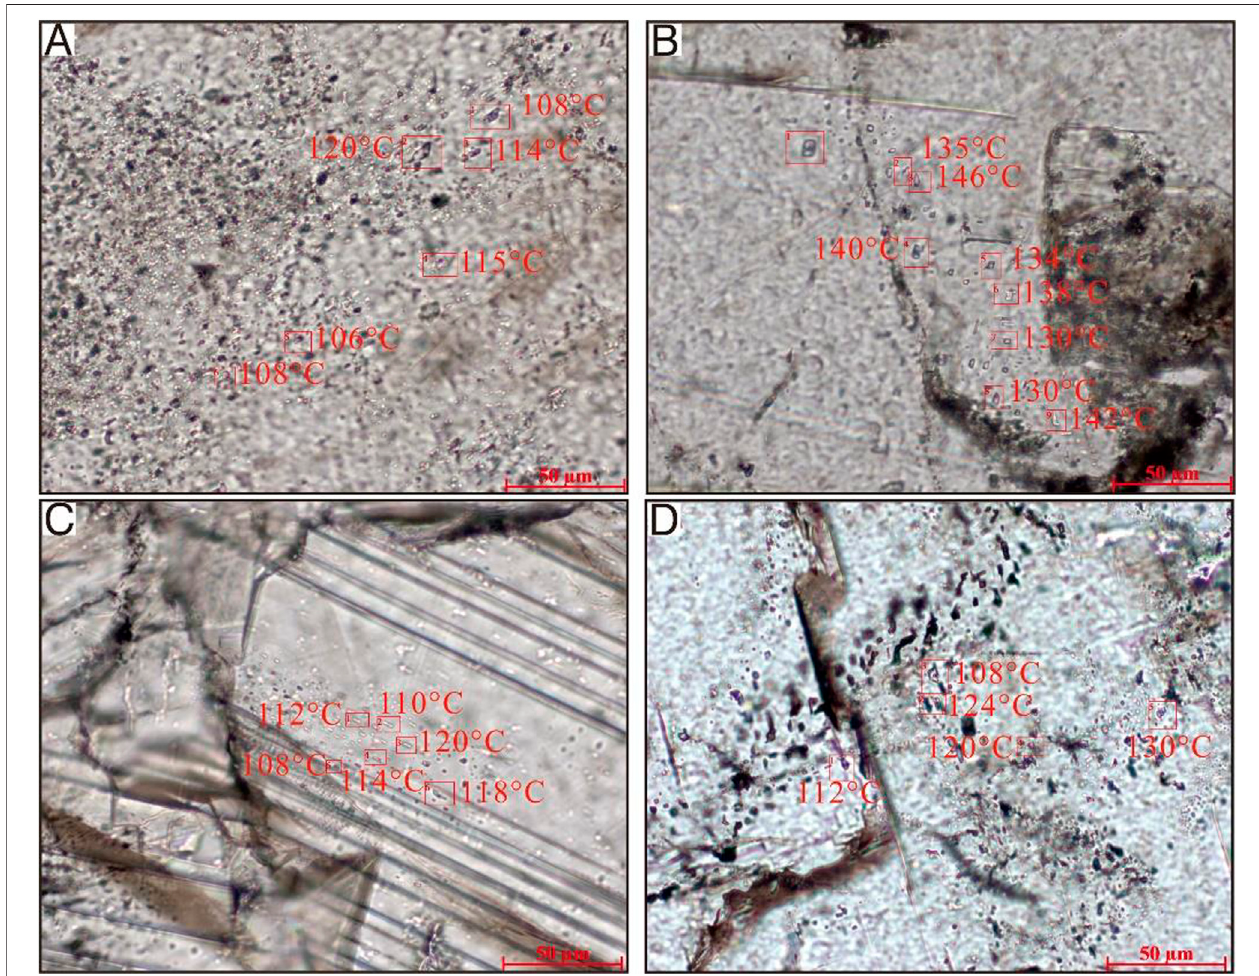
FIGURE 7 | Fluid inclusions in typical fracture fi llings of the Luzhou block. (A) , (B) . Well L201, 3,576.28, Longmaxi Formation; (C) . Well L206, 4043.20, Longmaxi Formation; (D) . Well Y101H3-8, 3779.36, Longmaxi Formation.